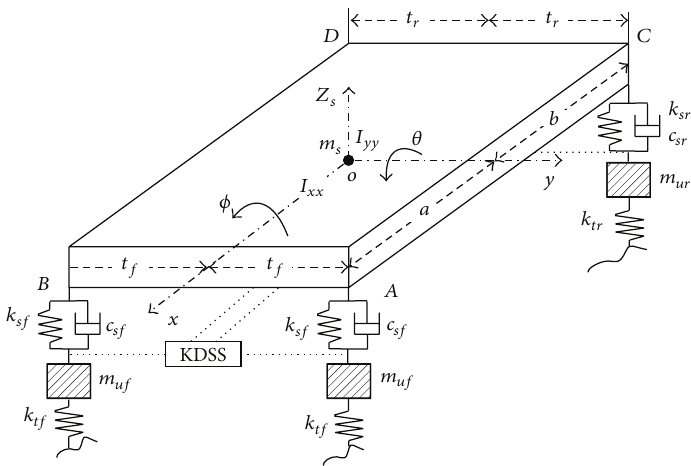
Figure 2: Schematic of a 7-DOF two-axle vehicle model with KDS system.